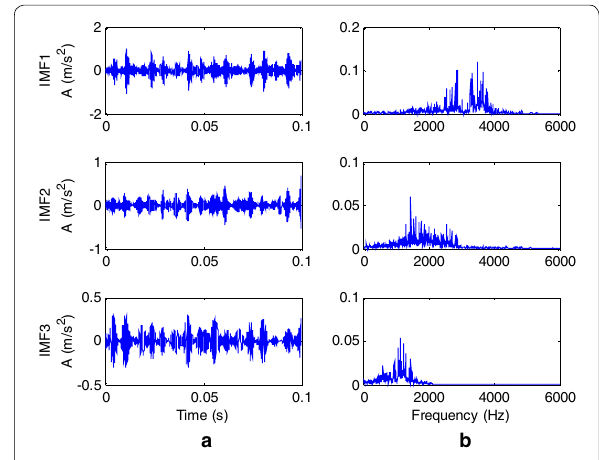
Figure 8 Bearing signal MMEMD decomposition result: ( a ) waveform, ( b ) amplitude-frequency